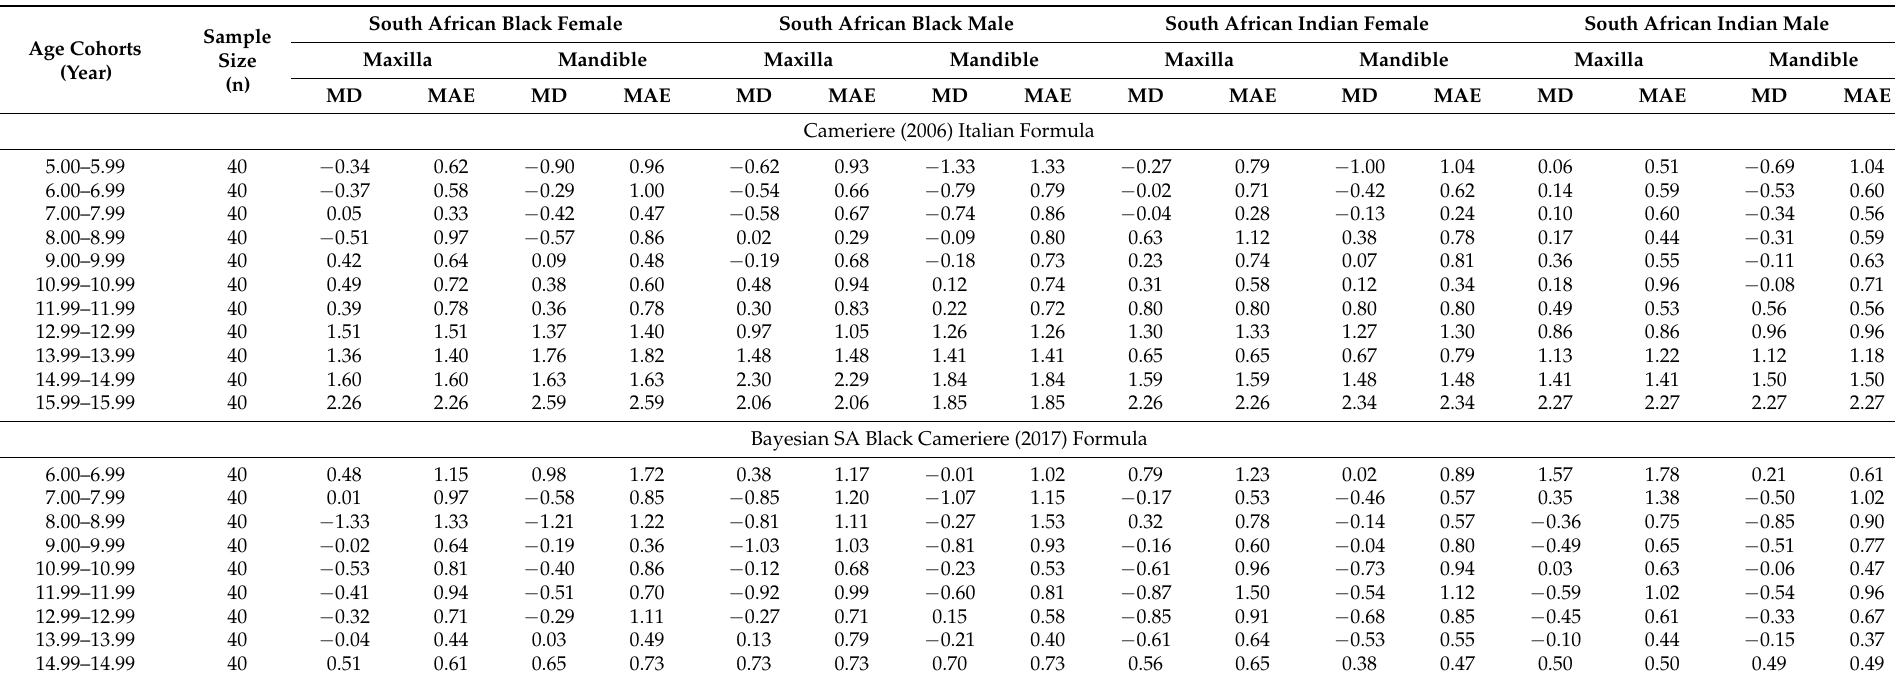
Table 3. Mean difference and absolute error using the Cameriere formulae for South African Black and Indian population group of KZN for each cohort (in